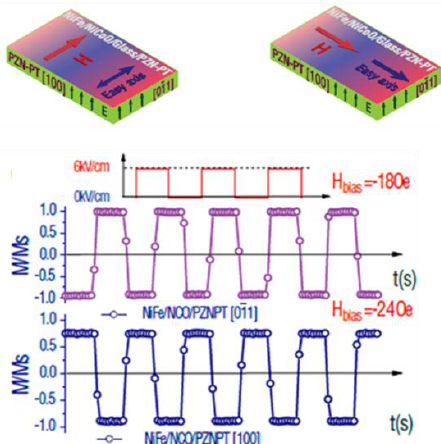
Figure 17. Magnetization switching by E-field in NiFe/NiCoO/glass/PZN-PT heterostructure-based MeRAM [117].